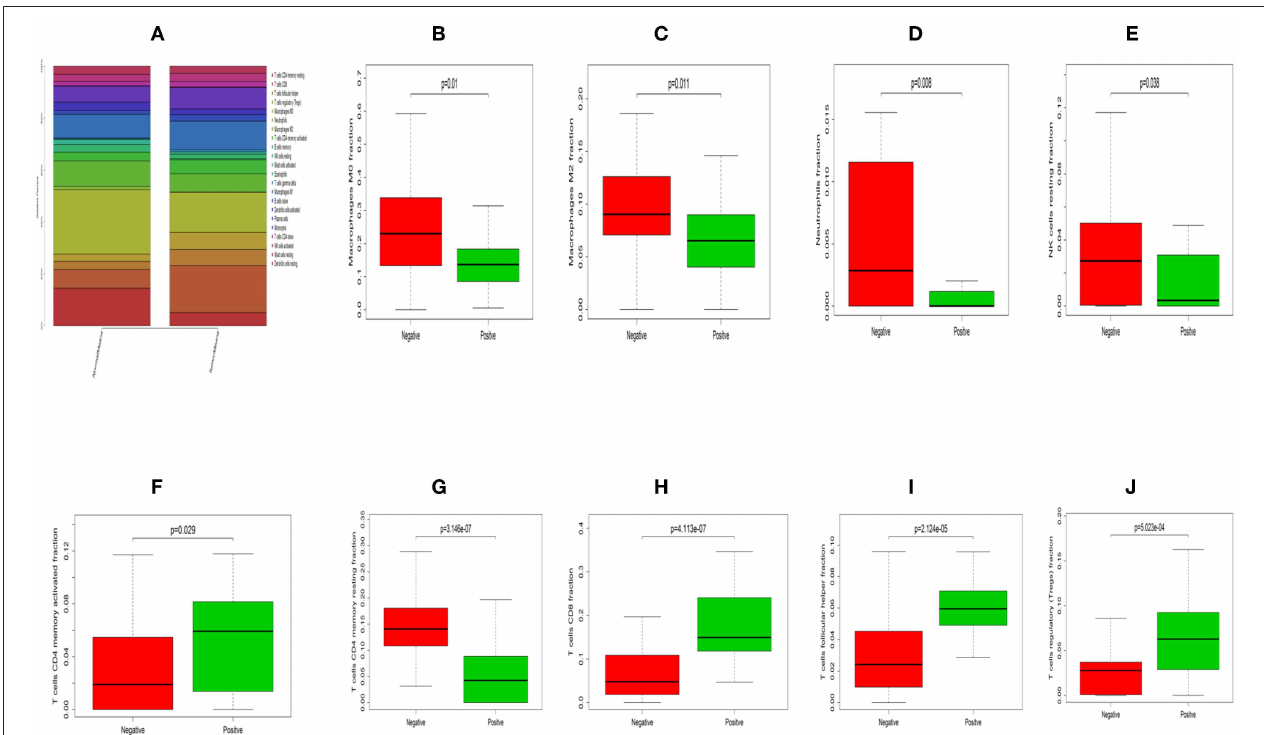
FIGURE 5 | The difference between immune infiltration between HNC HPV positive and negative samples. (A) The total difference in immune cells infiltration. Box plot of the distribution of CIBERSORT P value for Macrophages M0 (B) , Macrophages M2 (C) , Neutrophils (D) , NK cells resting (E) , T cells CD4 memory activated (F) , T cells CD4 memory resting (G) , T cells CD8 (H) , T cells follicular helper (I) and T cells regulatory (Tregs) (J) , respectively.